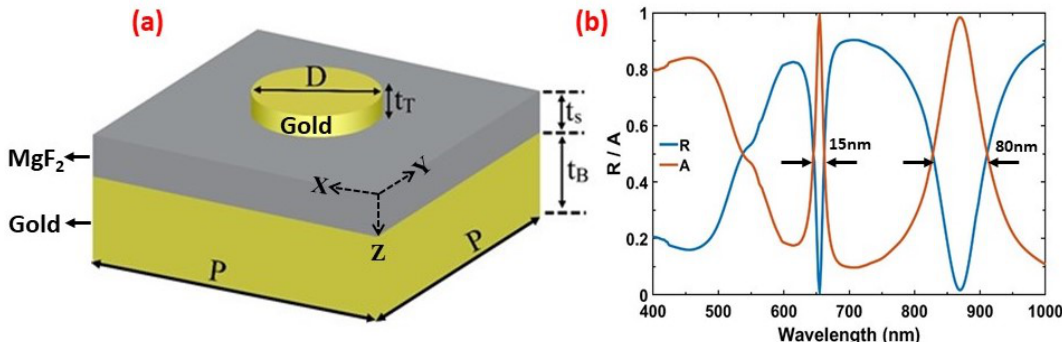
Figure 1. ( a ) A schematic of the unit cell of the proposed MIM metamaterial absorber with periodicity P . The optimized structural parameters are P = 600 nm, t B = 100 nm, t S = t T = 40 nm, and D = 180 nm. ( b ) Simulated reflection and absorption spectrum of the optimized metamaterial, yielding perfect absorption at dual spectral band at 653 nm and 865 nm with FWHM of 15 nm and 80 nm,